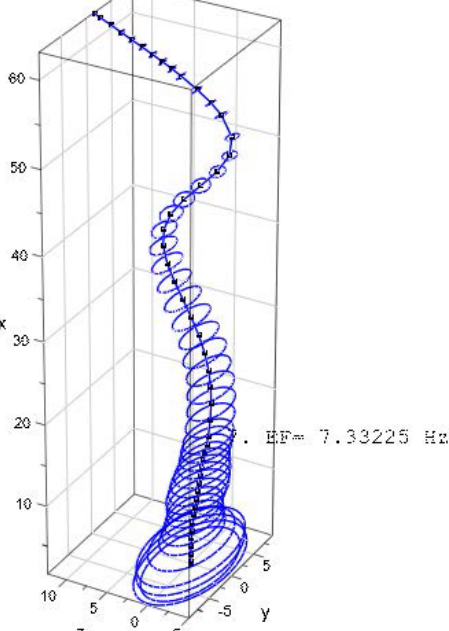
Figure 10. Third flapwise eigenmode.